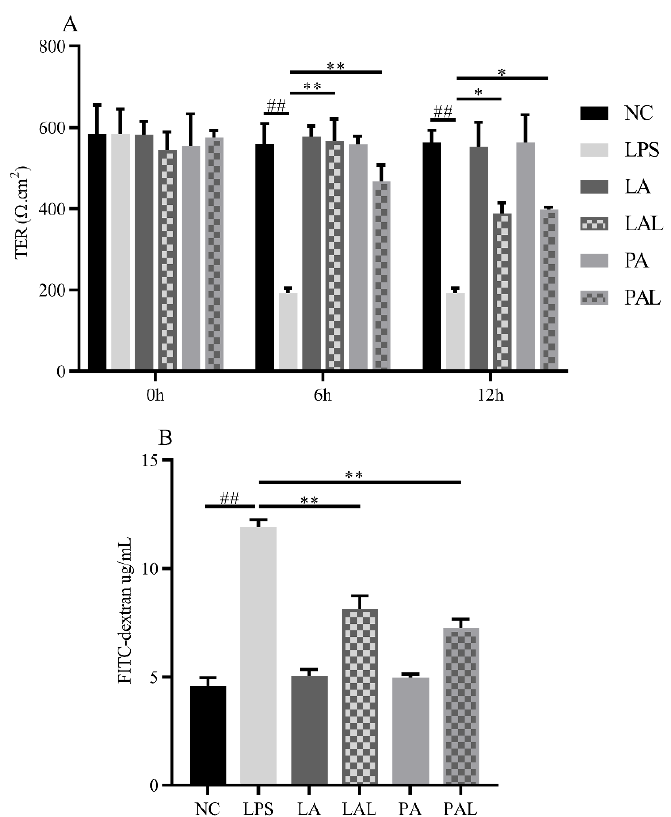
Figure 2. A. muciniphila improves the barrier function dysfunction induced by LPS. ( A ) The TER value and ( B ) FITC-dextran value of Caco-2 cell monolayers. ** p < 0.01, * p < 0.05, compared with LPS group. ## p < 0.01, # p < 0.05, compared with NC group. Data are expressed as mean ± S.D. ( n = 6). TER, transepithelial electrical resistance. FITC-dextran, fluorescein isothiocyanate-dextran. NC, control group. LPS, lipopolysaccharide-damaged group. LA, live A. muciniphila . PA, pasteurized A. muciniphila . LAL, live A. muciniphila + LPS. PAL, pasteurized A. muciniphila + LPS.